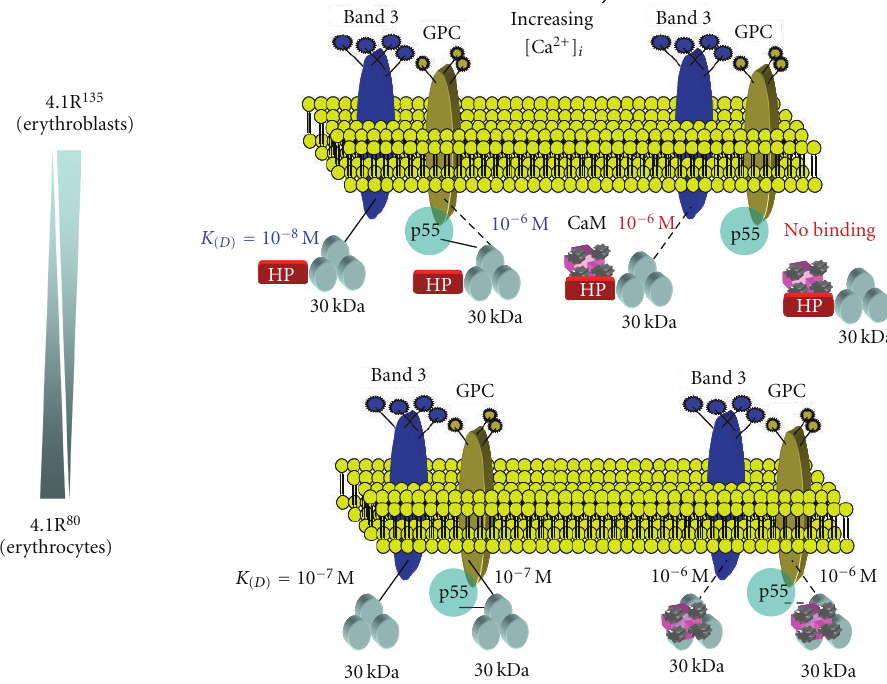
Figure 6: Model proposed for Ca 2+ /CaM-dependent regulation of 4.1R binding to membrane proteins. Erythroblast intracellular Ca 2+ concentration is normally maintained at less than 0.1 μ M (10 − 7 M) [39, 40] ( upper panel ). At higher Ca 2+ concentrations, CaM binds to the HP region. This results in a conformational and/or electric surface change which alters 4.1R binding sites, 4.1R 135 interacting consequently with lower a ffi nity with its binding partner band 3 and no longer interacting with GPC, and p55. This model implies a Ca 2+ /CaM-dependent regulation of protein 4.1R binding to transmembrane proteins. Erythrocyte intracellular Ca 2+ concentration is normally maintained at less than 1.0 μ M (10 − 6 M) (lower panel). At this Ca 2+ concentration, CaM is bound predominantly to the Ca 2+ -independent site located in peptide 11 of the 30 kDa domain ( see [12, 38]). At higher Ca 2+ concentrations, CaM-binding a ffi nity for the Ca 2+ -dependent site, located in peptide 9 of the 30kDa domain, increases. This results in a conformational and/or electric surface change which alters 4.1R binding sites, 4.1R interacting consequently with lower a ffi nity with its binding partners p55, GPC, and spectrin/actin. This model implies that CaM regulates protein 4.1R binding to transmembrane proteins through Ca 2+ -independent and Ca 2+ -dependent binding